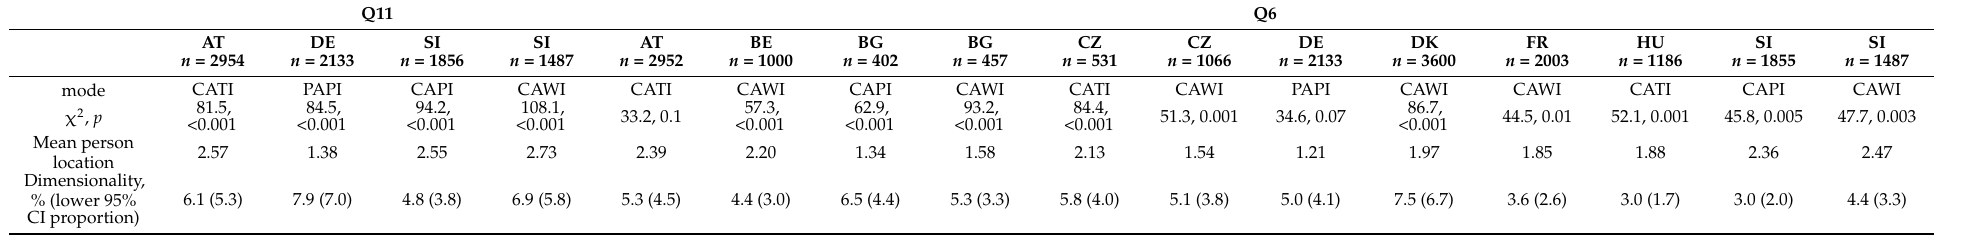
Table 4. Overall fit for HLS 19 -COM-P-Q11 (left) and HLS 19 -COM-P-Q6 (right) to the partial credit parametrization of the unidimensional polytomous Rasch model.